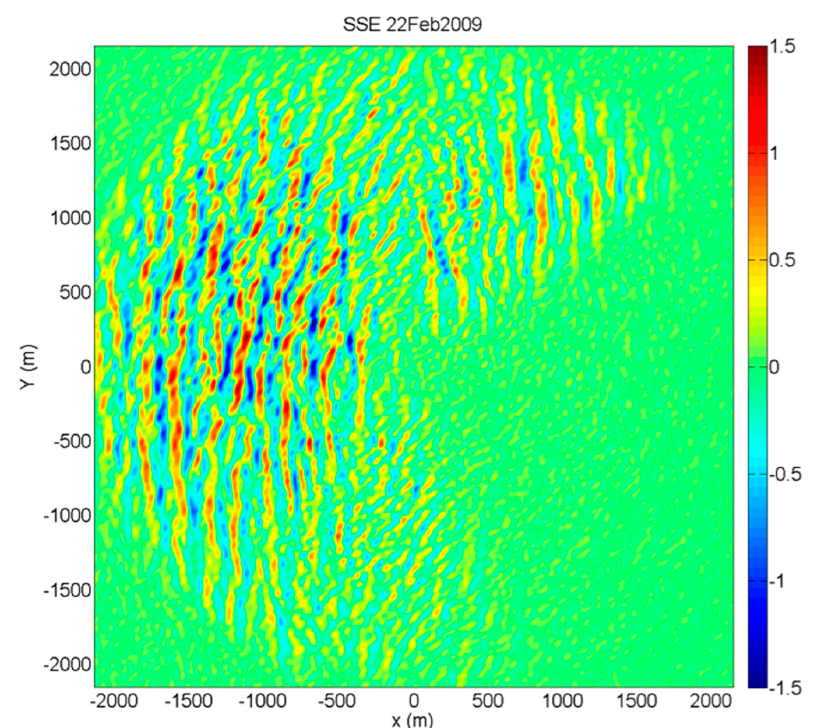
Figure 32. Conversion of radar measurements of Figure 19 to surface waves, see, for example, [Cheng and Chien, 17] [Lund et al., 45].